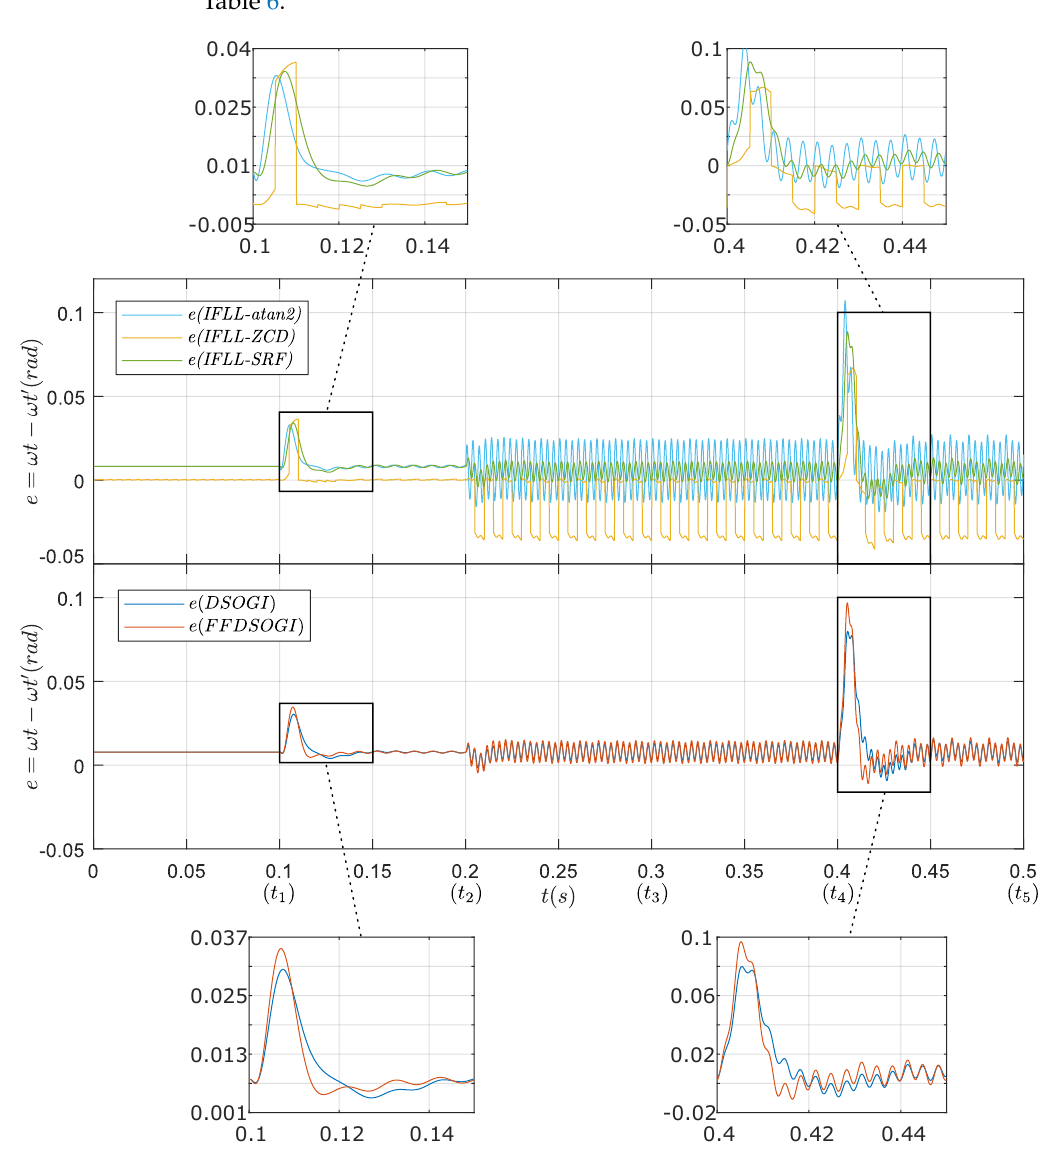
Figure 12. Estimated phase errors for the different methods during test #1. In the top figure, it is shown the different phase estimation methods applied to the IFLL, and in the bottom, the estimated phase by the PLL methods. Table 6. Steady-state estimated phase angle RMSE and ME obtained during test